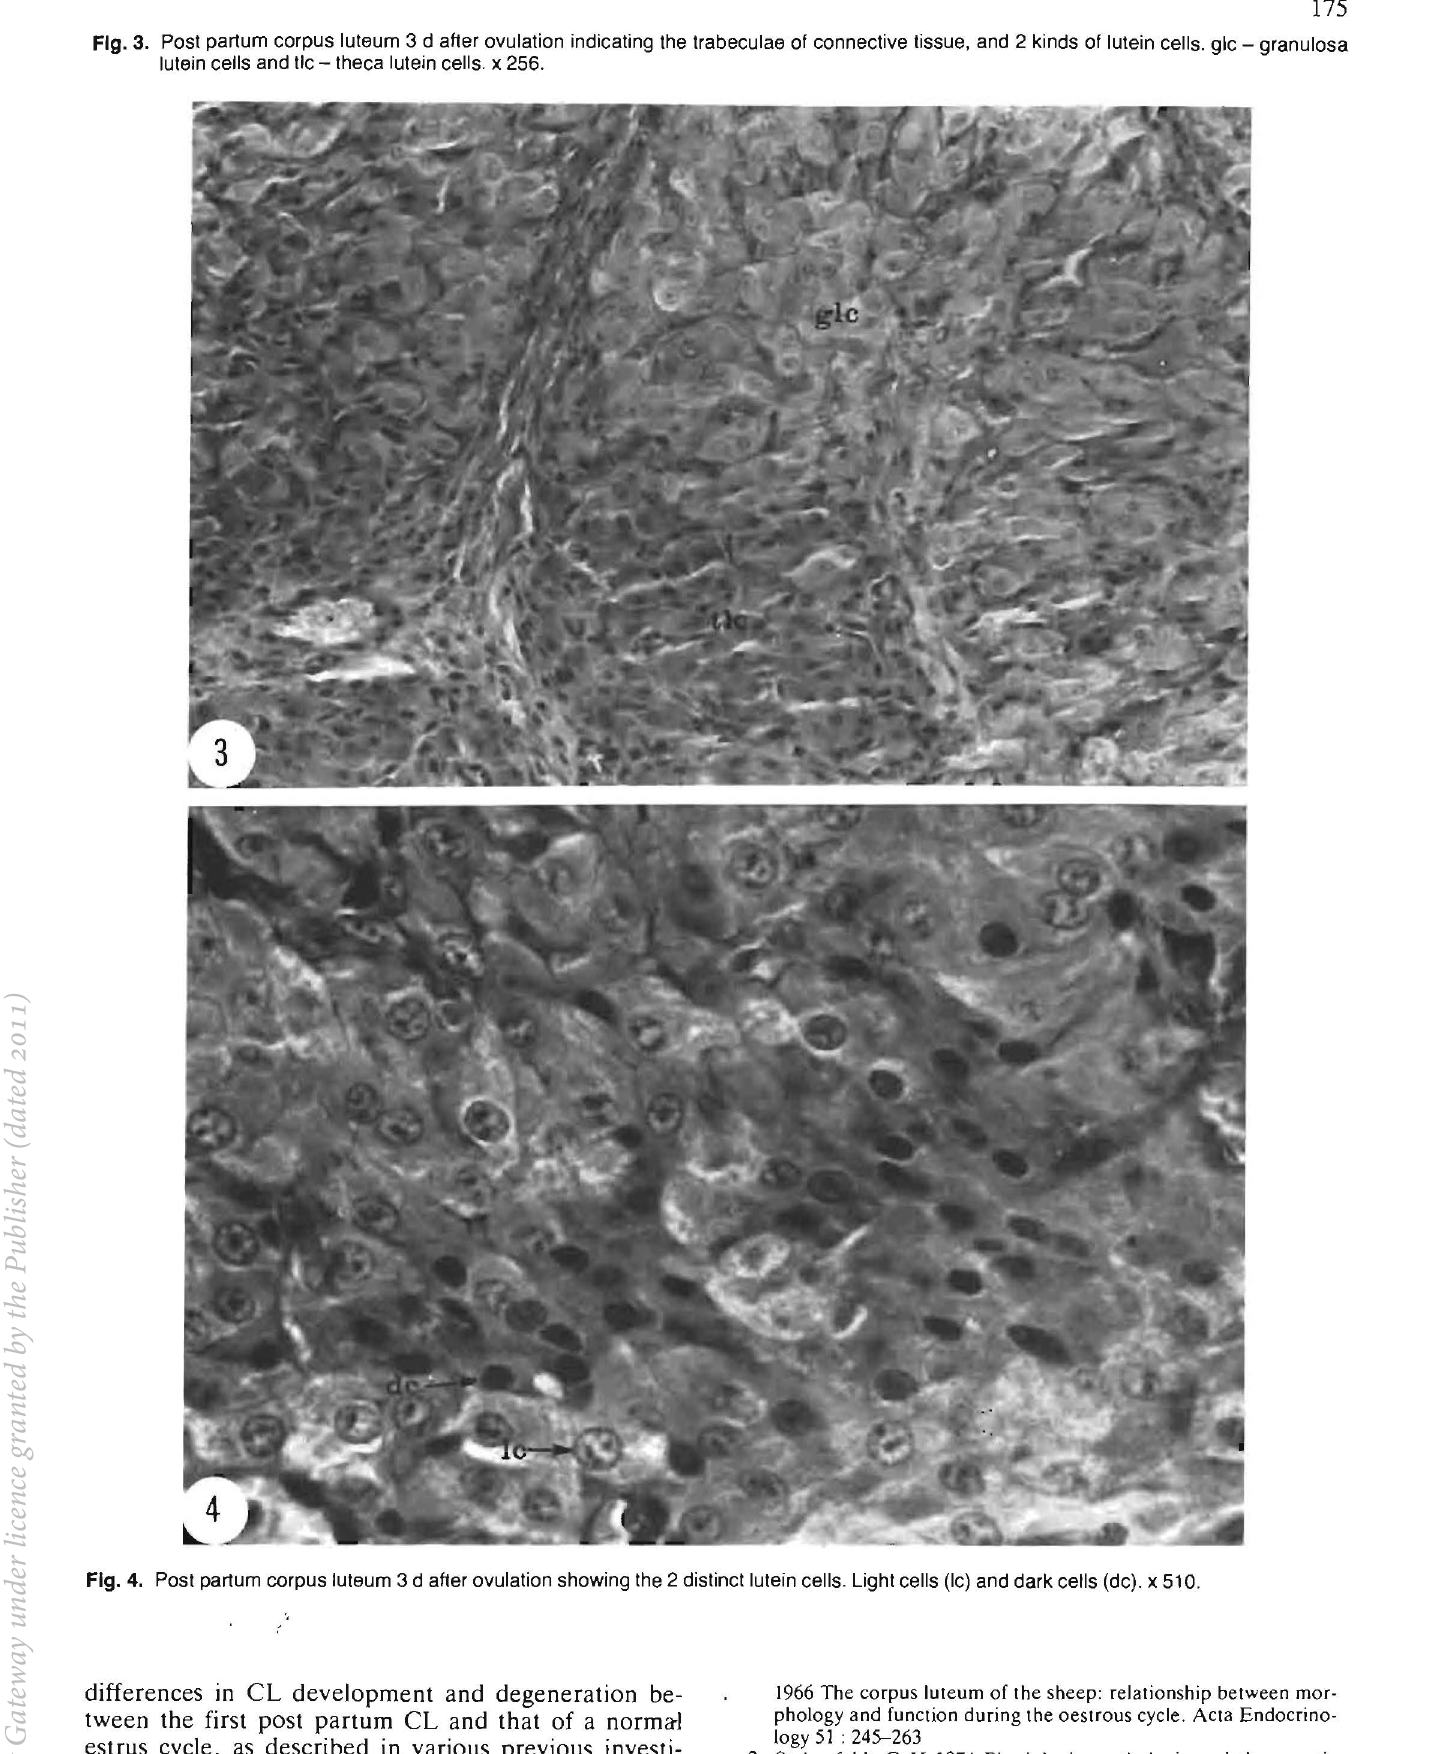
Fig. 4. Post partum corpus luteum 3 d after ovulation showing the 2 distinct lutein cells. Light cells (Ic) and dark cells (dc). x